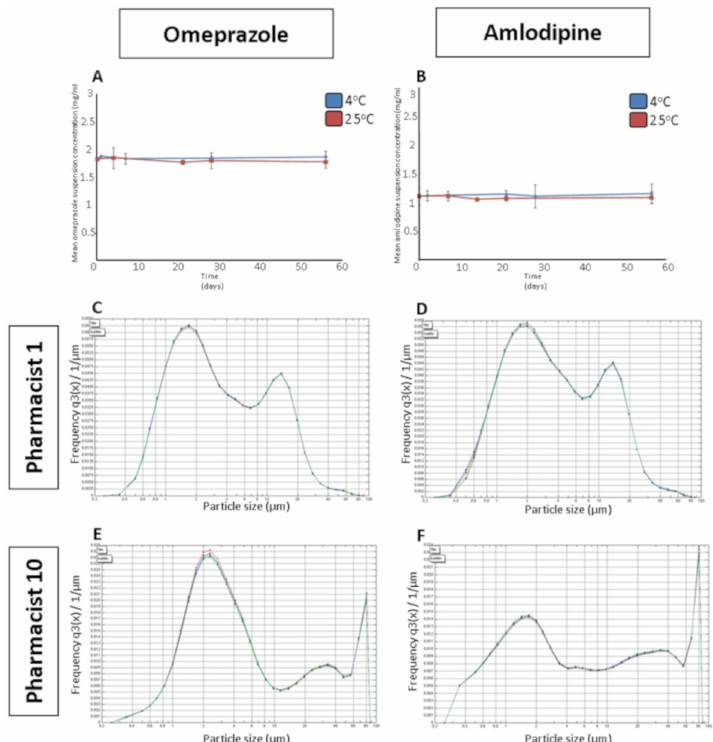
Figure 1. The stability profile of extemporaneously prepared ( A ) omeprazole and ( B ) amlodipine suspensions over a 56-day period stored at 4 ◦ C and 25 ◦ C. Statistical significance was determined using a Wilcoxon Signed Rank test, n = 5. Di ff erences in the particle size distribution of suspensions prepared by pharmacist 1: ( C ) omeprazole, ( D ) amlodipine, and pharmacist 10: ( E ) omeprazole, ( F )